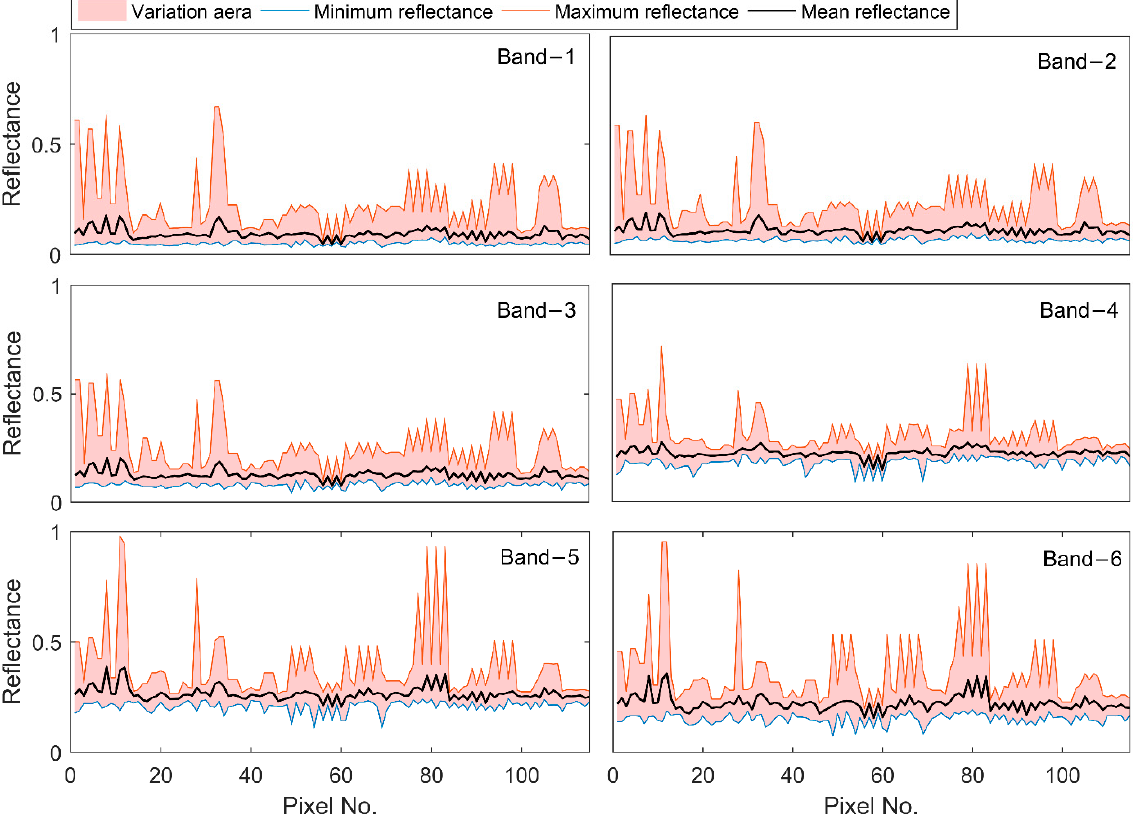
Figure 11. Reflectance variation of 5 × 5 artificial pixels from Sentinel − 2A.